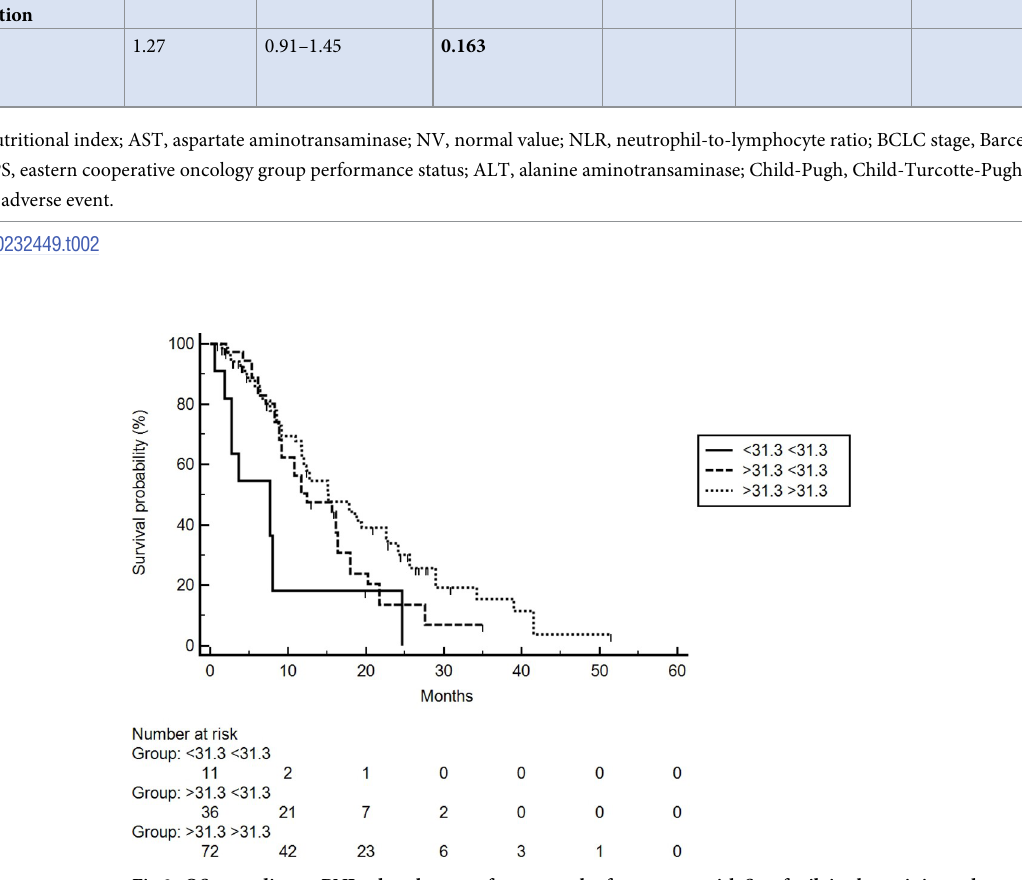
Fig 2. OS according to PNI value changes after a month of treatment with Sorafenib in the training